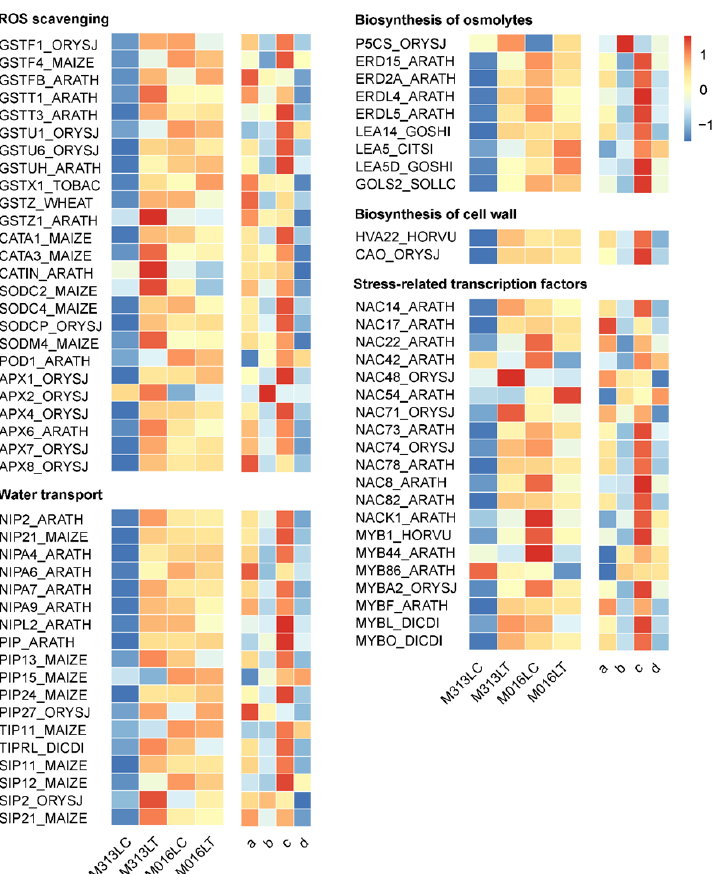
Figure 6. Heatmap of drought-tolerance-related genes in the leaves of diploid and tetraploid M. lutarioriparius . Red and blue colors represent up-regulated and down-regulated transcripts, respectively. The darker the color is, the greater the difference of genes expression level is. a, M313T vs. M313C; b, M016T vs. M016C; c, M016C vs. M313C; and d, M016T vs. M313T.